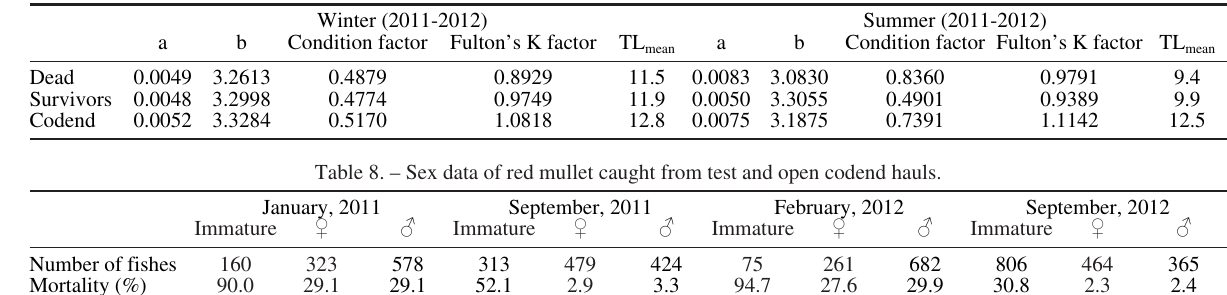
) in the test cages and mean